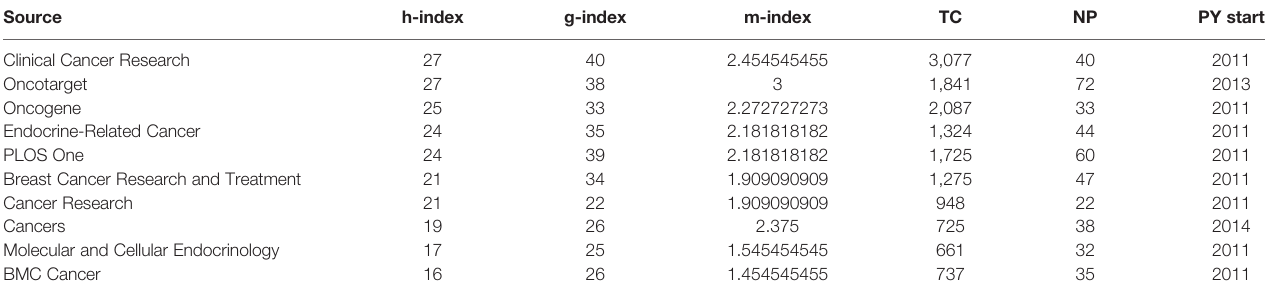
TABLE 3 | Source impact of the top 10 journals publishing in this area. Source